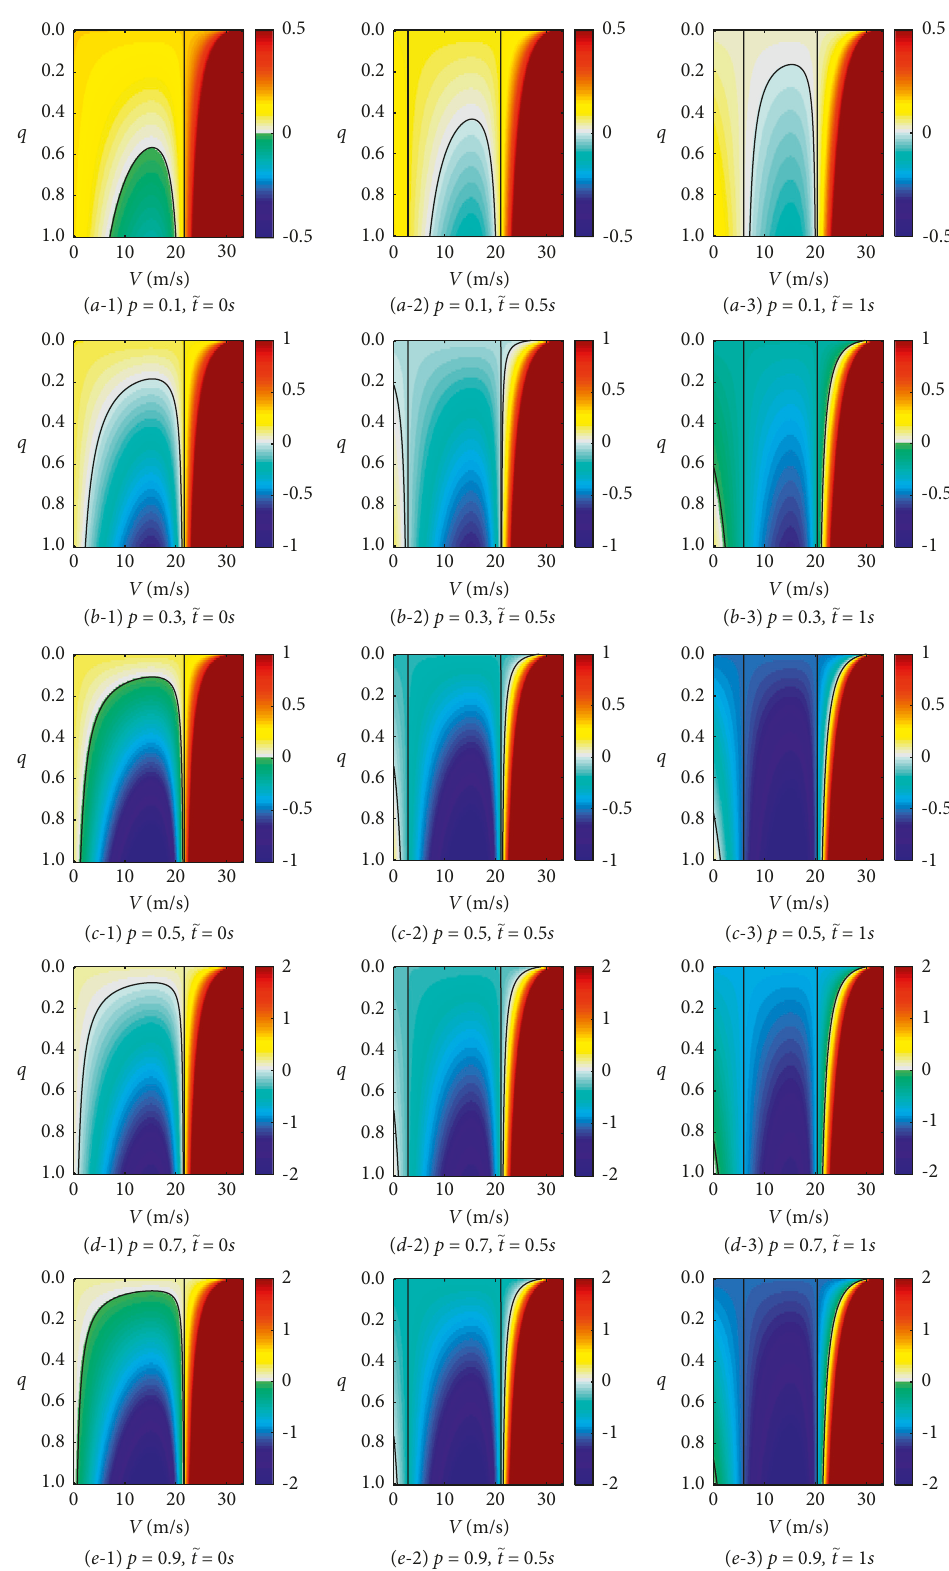
Figure 4: Stability values for heterogeneous traffic flow under different